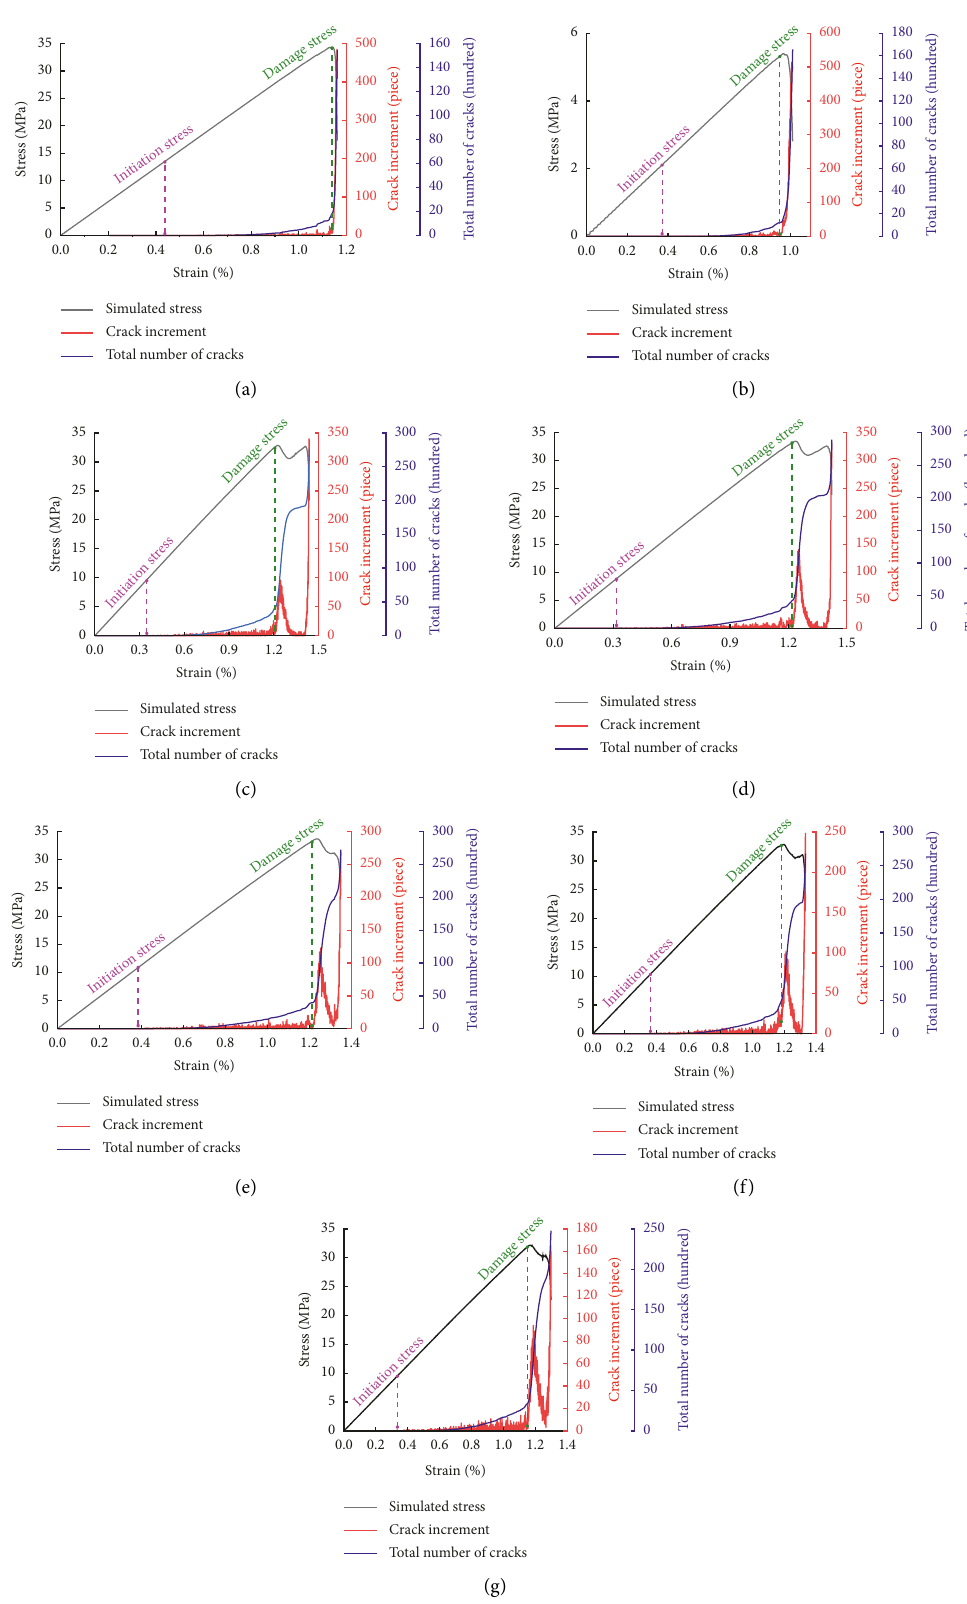
Figure 15: Crack evolution curves. (a) Single body artificial dam, (b) single body coal pillar, (c) 50 ° combined body, (d) 60 ° combined body, (e) 70 ° combined body, (f) 80 ° combined body, and (g) 90 ° combined